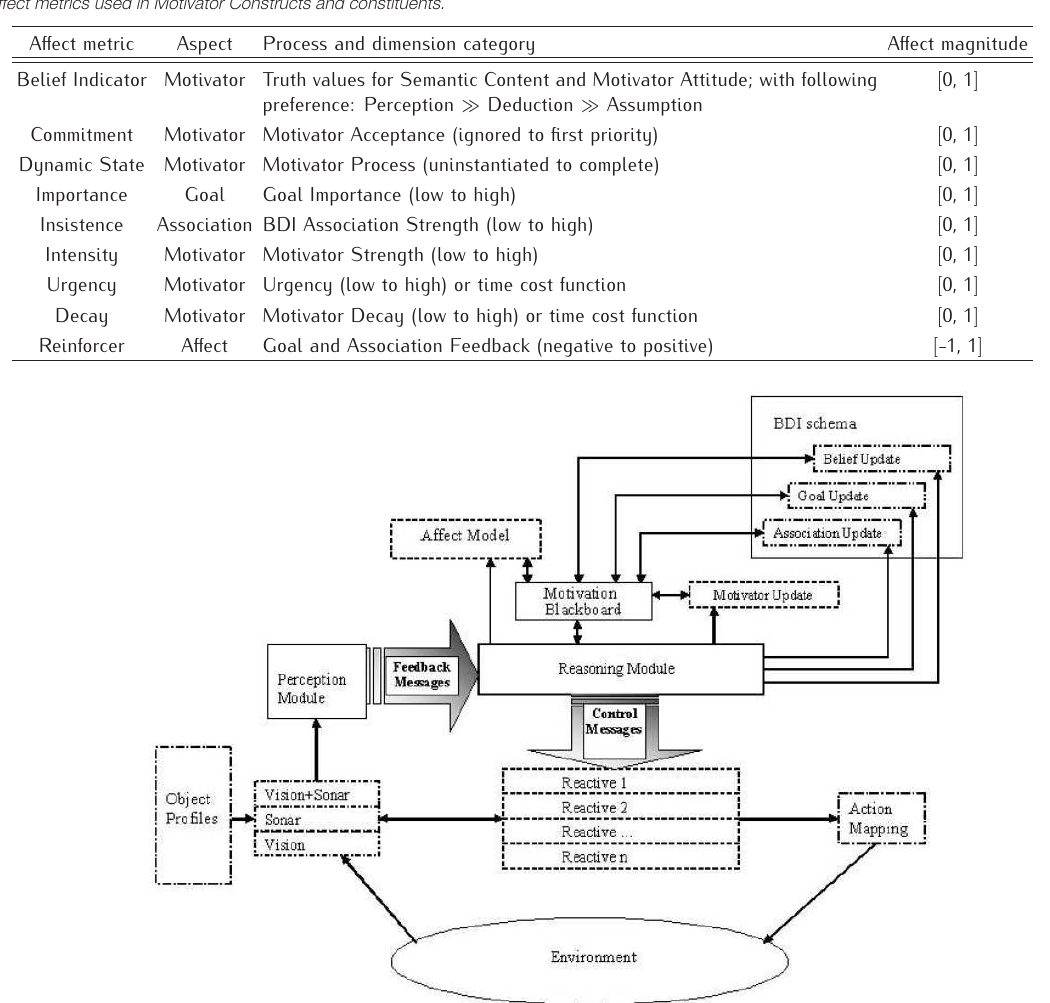
Figure 3. The robo-CAMAL